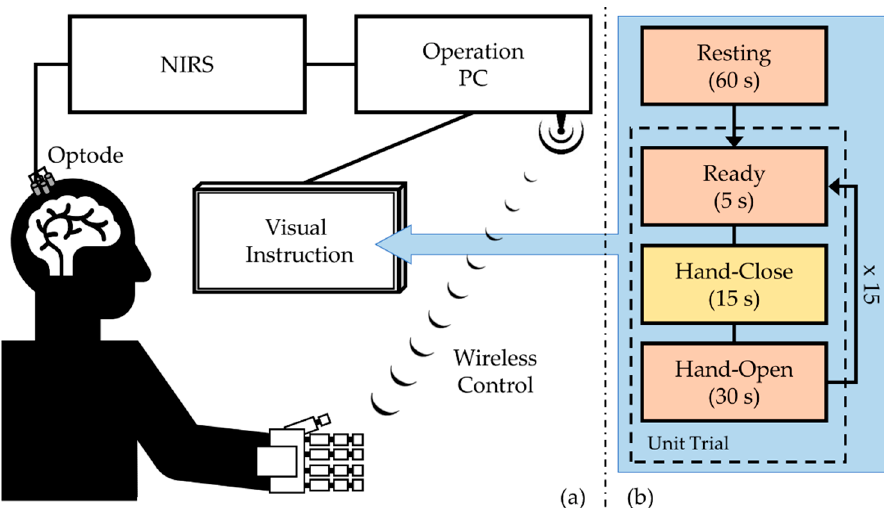
Figure 1. System Configuration and Experimental Design: ( a ) System Configuration. The system consists of three basic components: a near-infrared spectroscopy (NIRS) system, a robotic hand orthosis, and an operating personal computer (PC). The NIRS system measures changes in local [Hb] in the motor cortex and sends them to the PC. The PC detects hand motor intentions from the NIRS data and wirelessly triggers the robotic orthosis; ( b ) Experimental Design. One session had a resting state period and a task period comprising 15 repeated unit trials. A unit trial was a sequence of ready, hand-closing, and hand-opening periods. The duration of the whole session was 810